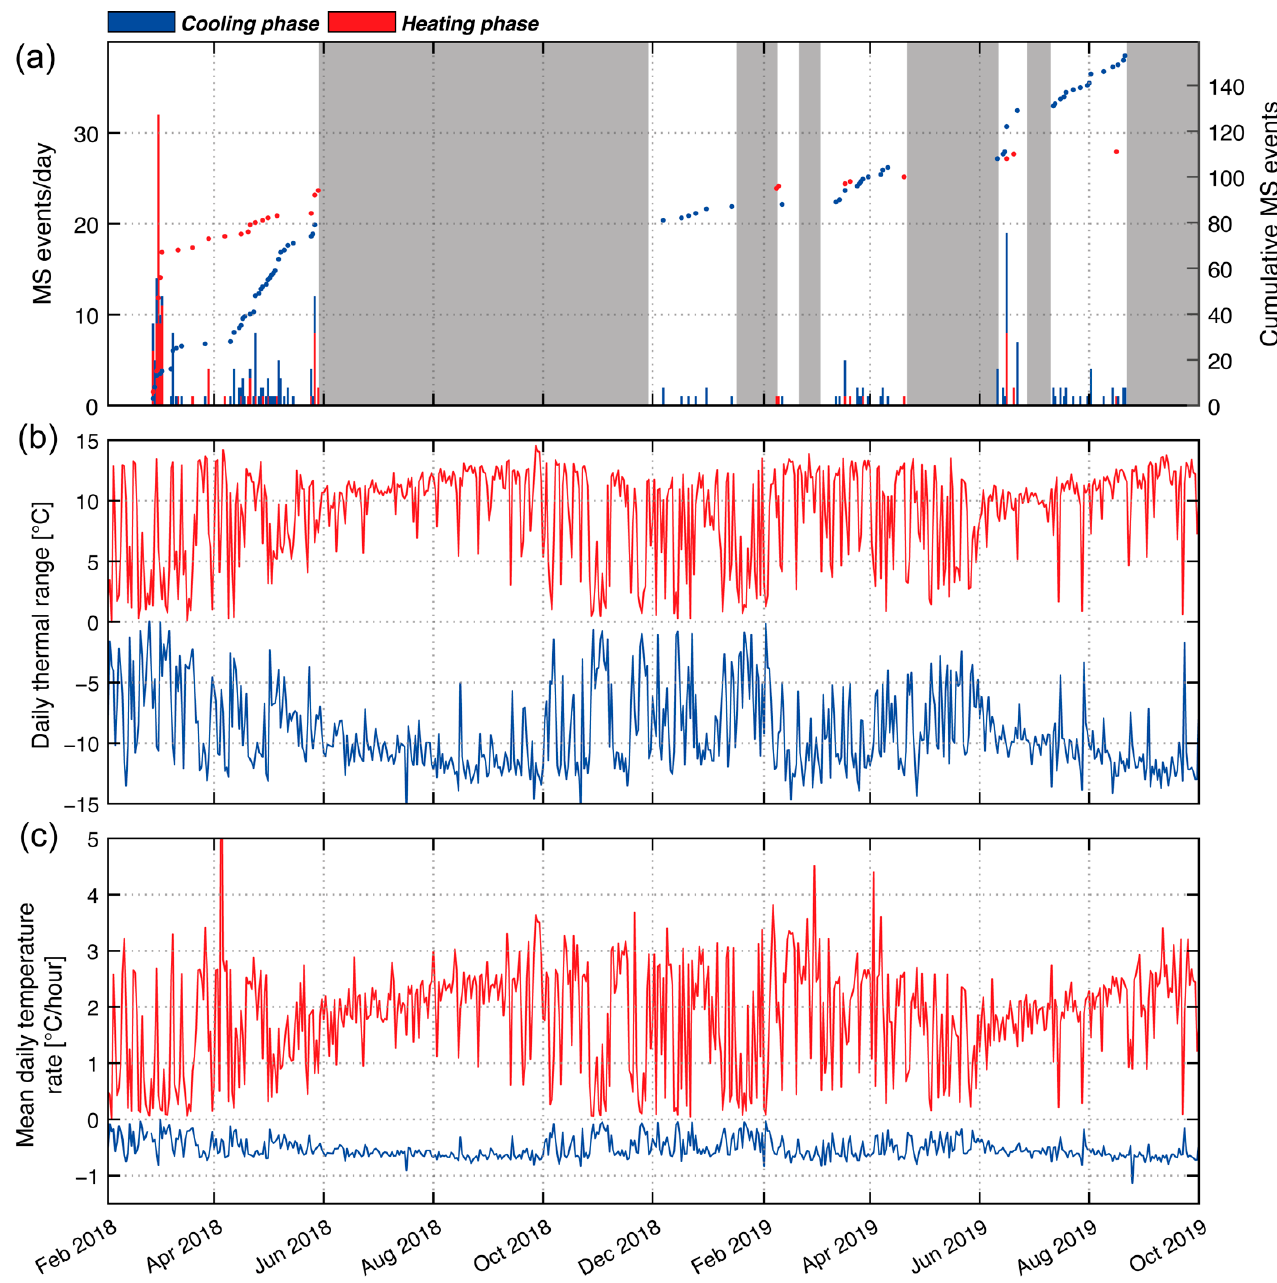
Figure 11. Comparison between the distribution of MS events ( a ), daily thermal ranges ( b ), and mean daily temperature rates ( c ). In each plot, the distinction between the heating (in red) and cooling (blue) phases of the rock mass is proposed with a view to investigate the response of the jointed rock block to different thermal regimes of increasing (heating) or decreasing (cooling) temperatures. Gray areas in panel ( a ) represent periods in which the MS monitoring network was not working due to power supply interruptions.